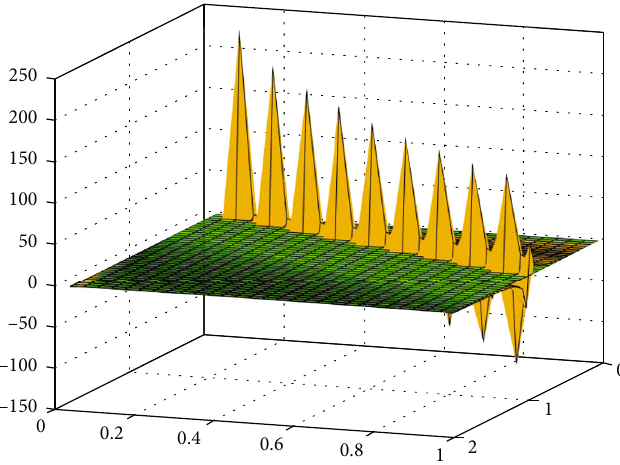
Figure 3: Three-dimensional illustration of the error and error bounds for